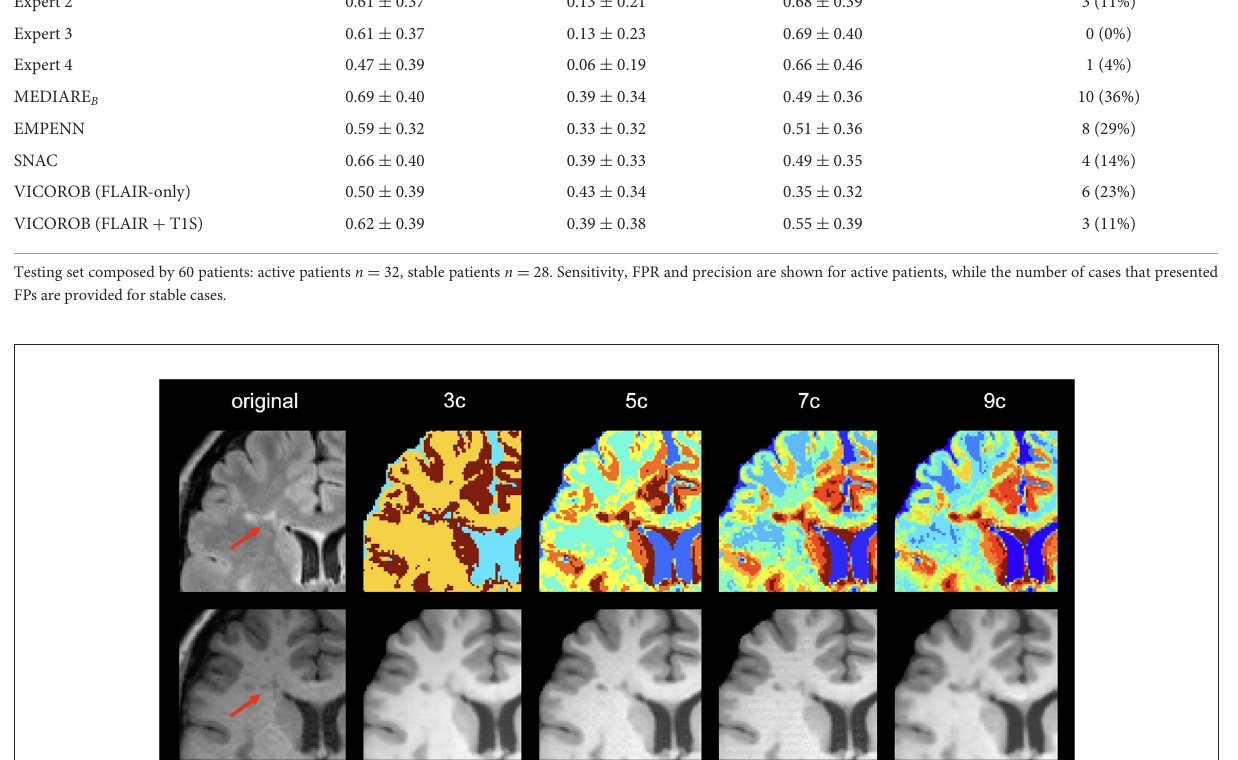
clusters does not account for the inherent partial volumes of